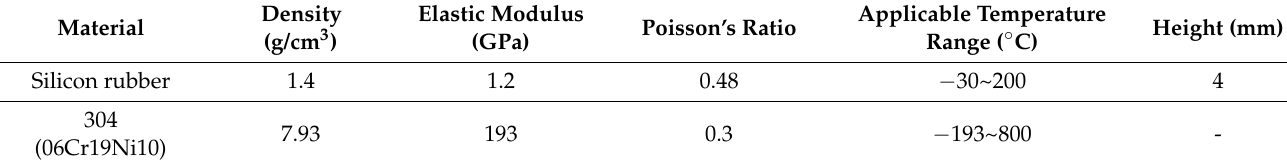
Figure 4. Schematic diagram of the MR- and SR-based LCDS. Table 2. SR and metal wires parameters.